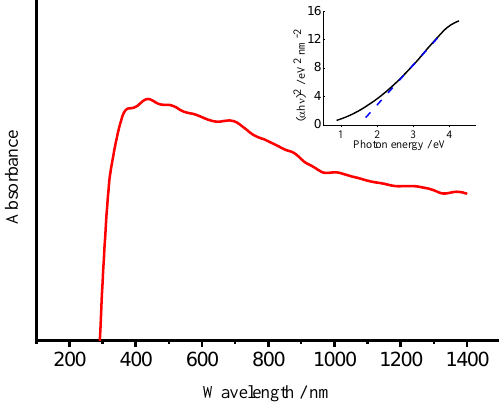
Figure 19. UV–visible near-infrared diffuse reflectance spectrum of the NG sample. Tauc-plots for the direct band-gaps of the NG sample.